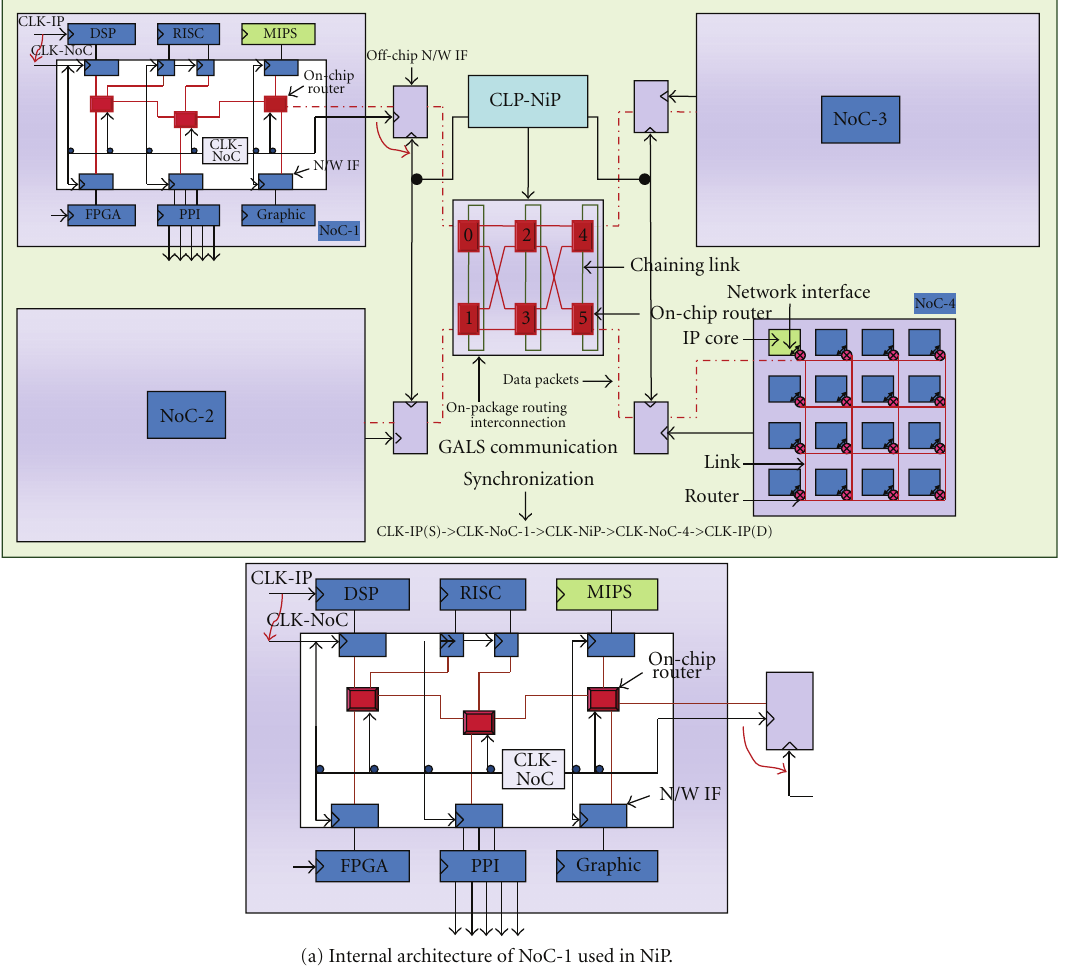
Figure 2: Parallel communication among various NoCs using